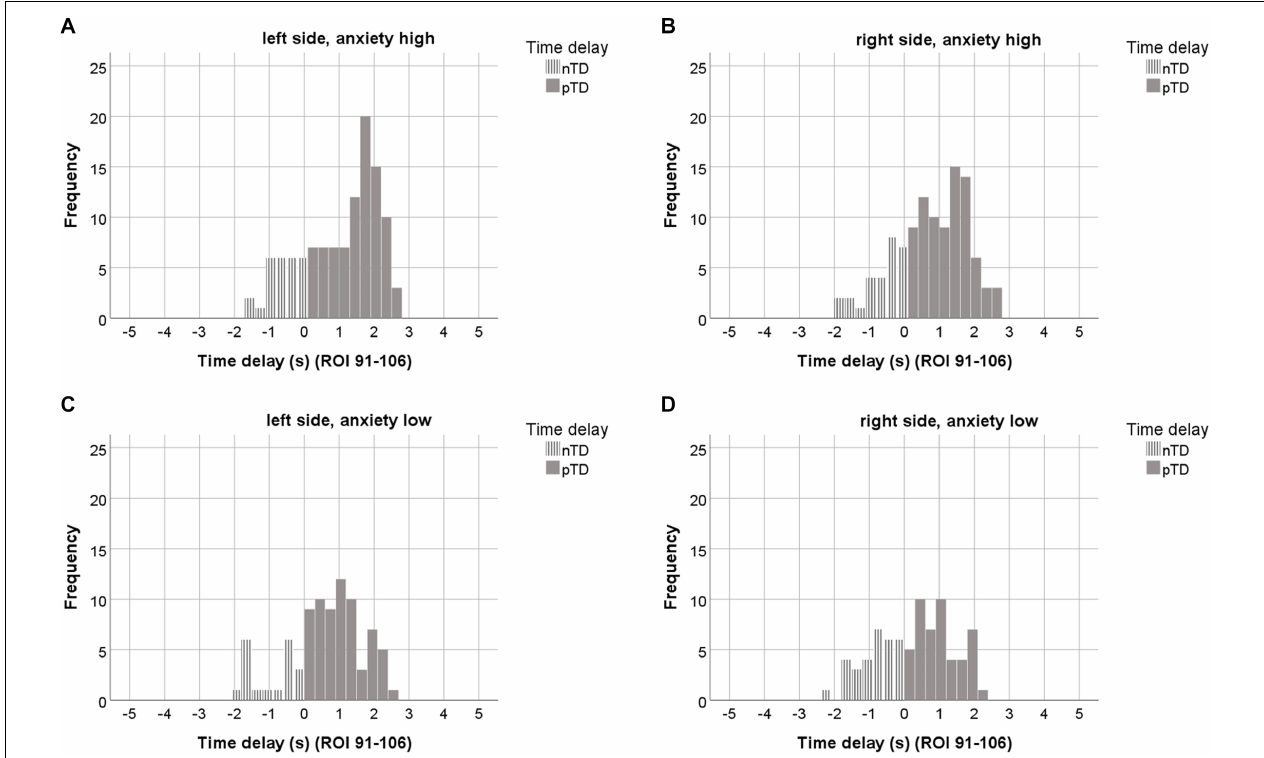
FIGURE 5 | The upper row depicts histograms of TDs from the “high anxiety” category (23 subjects, 7 ROIs out of ROIs 91–106) for the left (A) and right side (B) . The lower row shows TD histograms from the “low anxiety” category for left (C) and right side (D) . ROIs with odd numbers represent the left, ROIs with even numbers the right brain side. Histograms representing pTDs (between 0.1 and 3 s) are indicated by dark gray